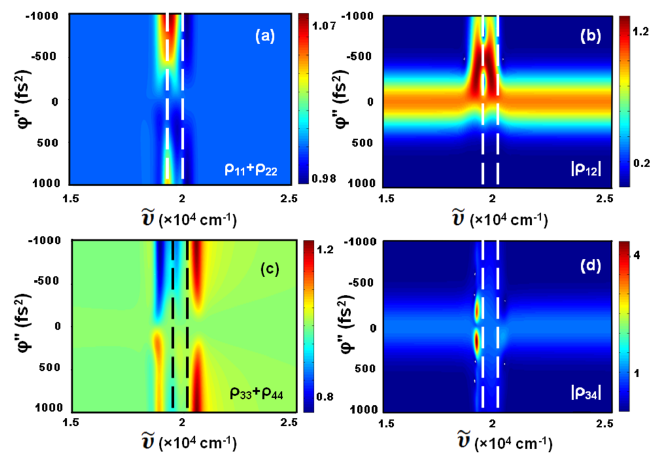
Figure 2. Enhancement/suppression factor of ( a ) population in the ground state; ( b ) vibrational coherence in the ground state; ( c ) population in the upper state; and ( d ) vibrational coherence in the upper state. Dashed lines indicate the position of the excited states (see Figure 1).